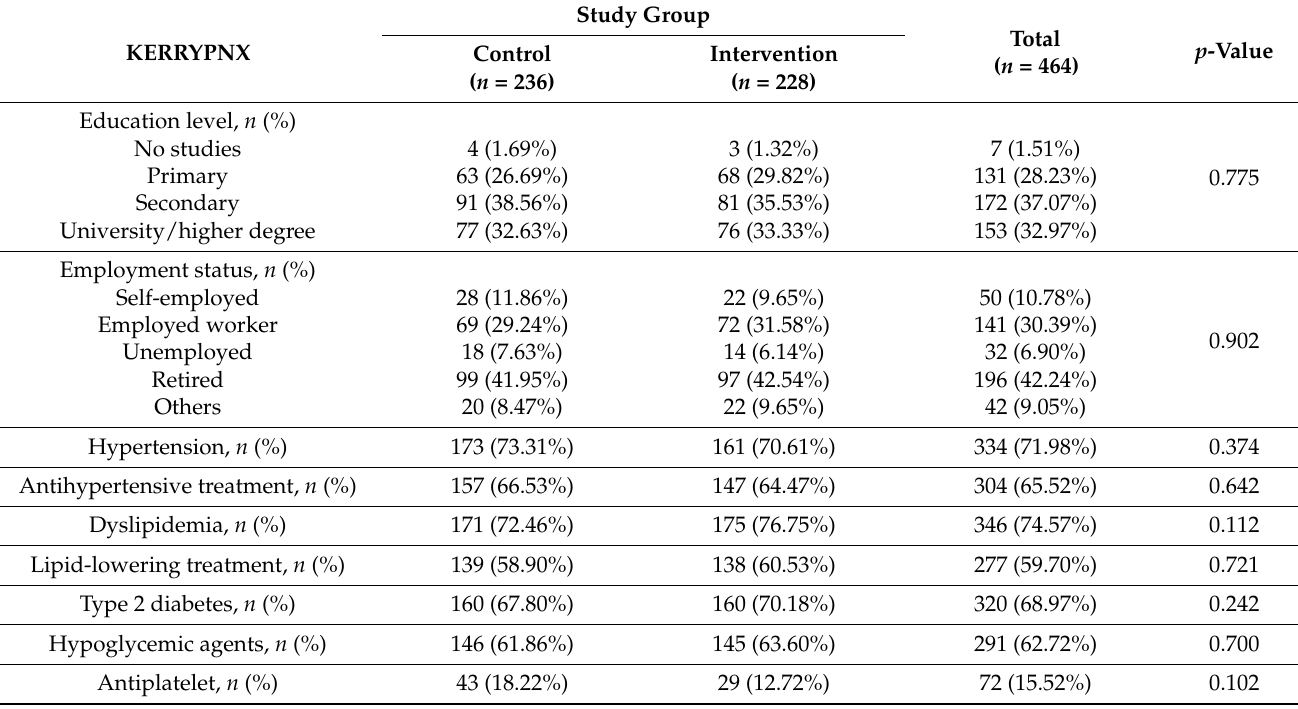
Table 1. Baseline characteristics of the study